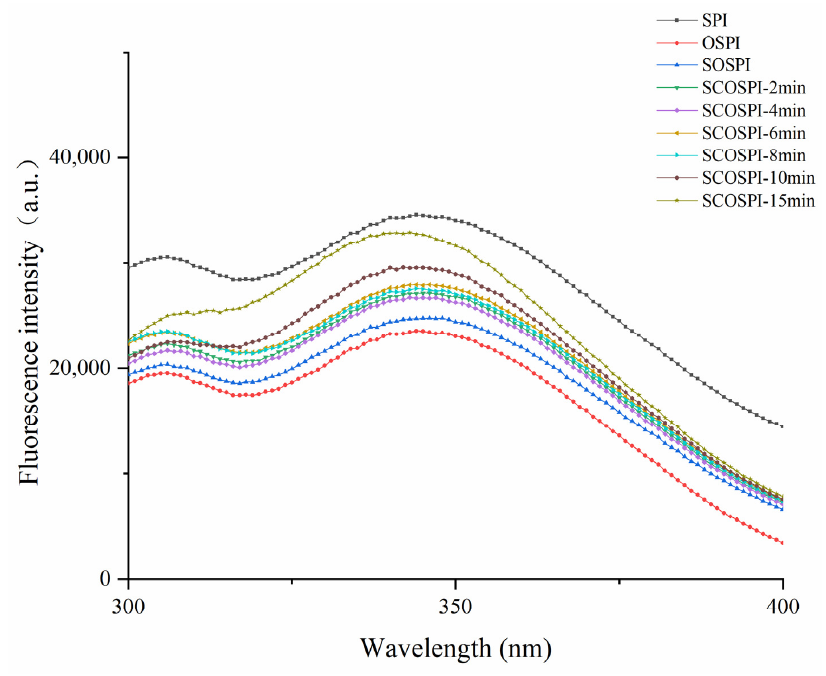
Figure 4. Fluorescence emission spectra of natural, oxidized soybean protein, and cavitation jet treated on soluble soybean protein oxidized accumulates at several times (2, 4, 6, 8, 10, and 15